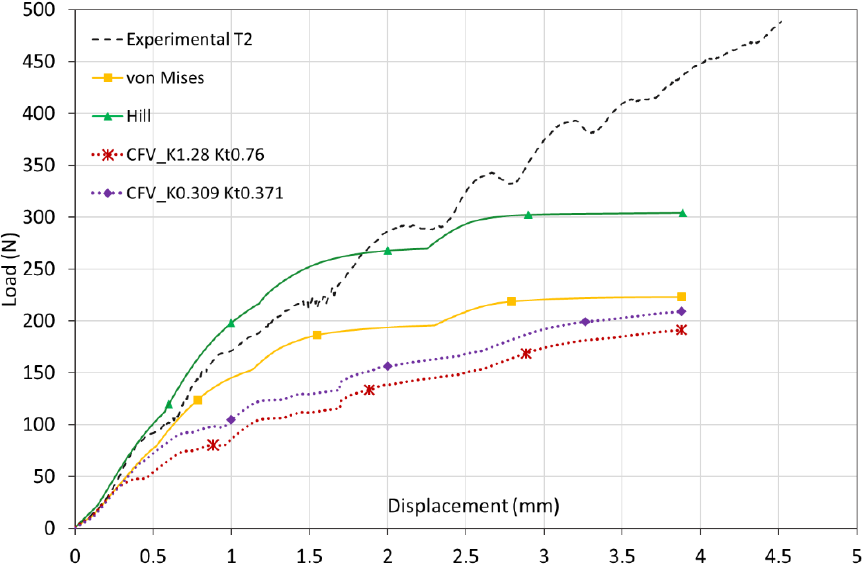
Figure 13. Comparison of experimental load – displacement curve with numerical of roller indenta- tion test using CFV, von Mises and Hill’s constitutive models to represent trabecular bone behav-